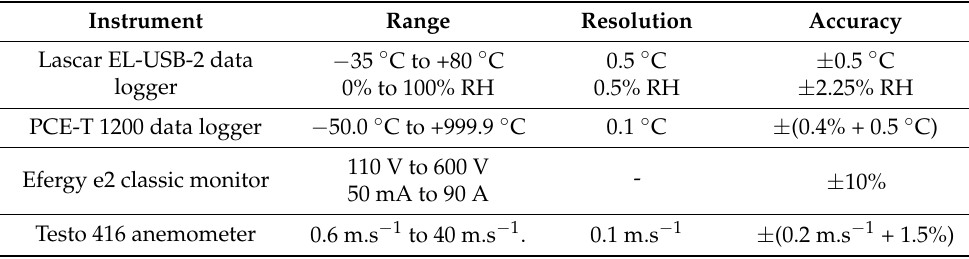
Table 2. Accuracy of the equipment used in the experimental